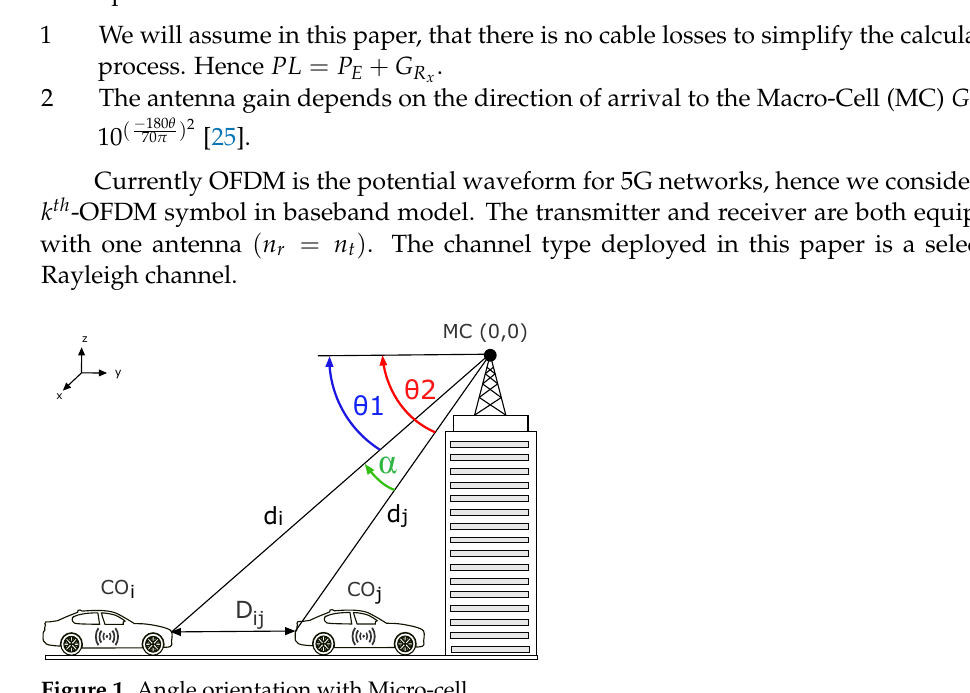
Figure 1. Angle orientation with